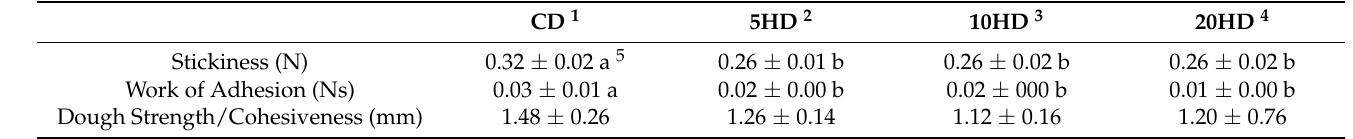
Table 7. Surface-related qualities of control and hemp seed flour-containing